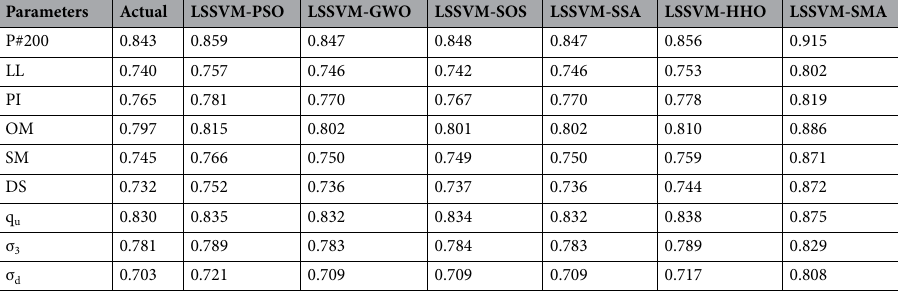
Table 9. Results of sensitivity analysis for the developed hybrid LSSVMs.